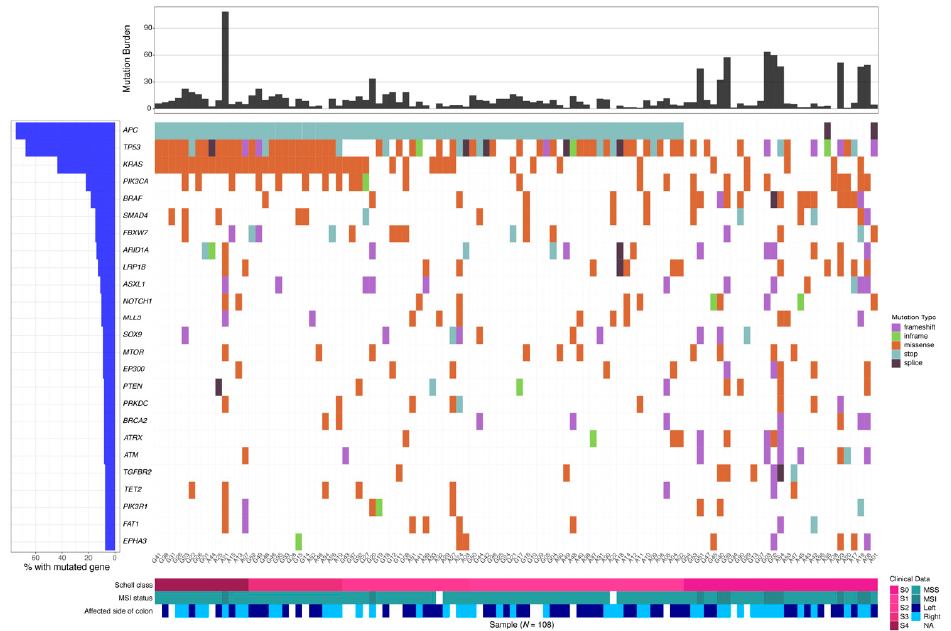
Figure 5. Mutational landscape of metastatic colorectal cancer patients. Each patient is represented by a column, showing mutated genes, tumor mutation burden, Schell class, microsatellite instability status, and side of the colorectal cancer.